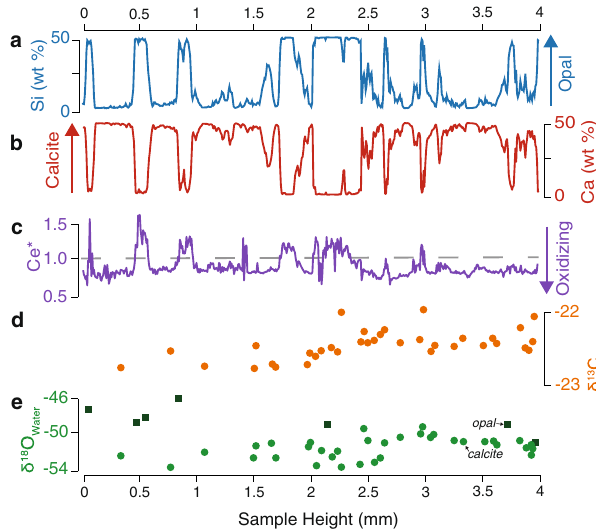
Fig. 5 | Geochemical Data from PRR50489. a LA ICP-MS Si concentration curve. b LAICP-MSCaconcentrationcurve. c LAICP-MSCe*curve. d δ 13 Cdatafromcalcite layers. e δ 18 Odatafromcalciteandopallayers.Opallayersarerepresentedbyareas with high Si and low Ca concentrations; calcite layers have high Ca concentration and low Si